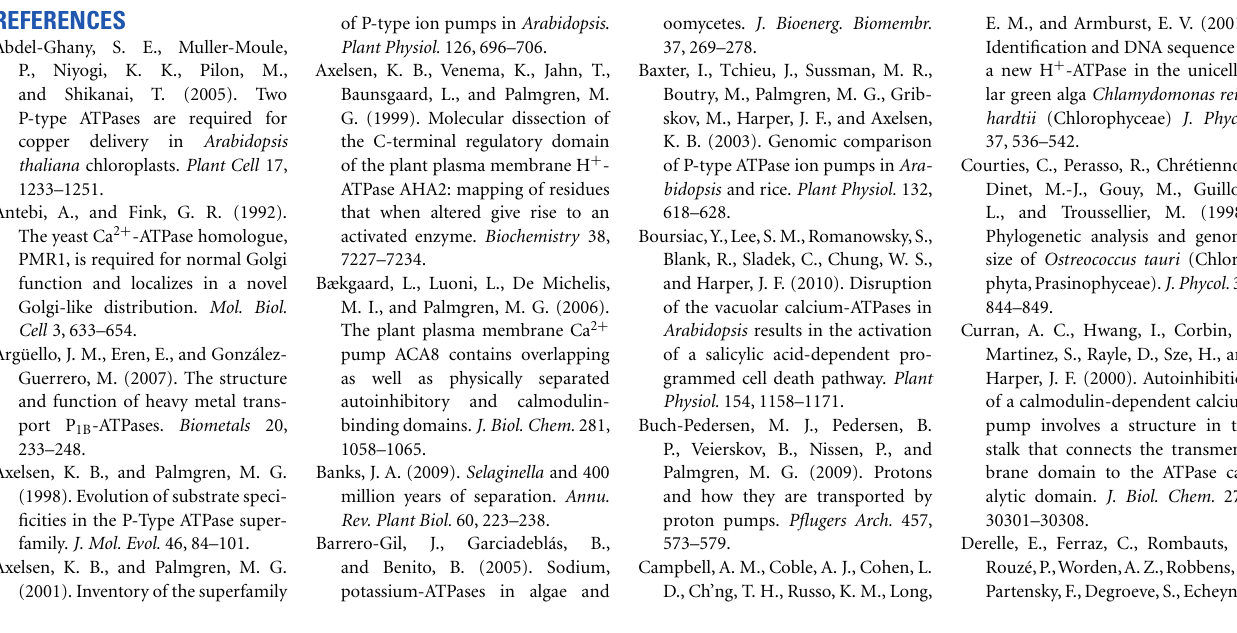
pump (P3A). In present day plants, the terrestrial green algae C. reinhardtii still has all three types of pumps whereas Na + pumps have been lost completely in vascular plants (here represented by Lycopodiophyta and